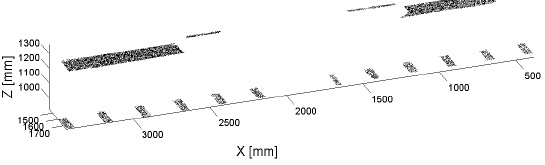
Figure 7. Example of the photogrammetric reconstruction for the 0 mm load stroke epoch for one of the experiments